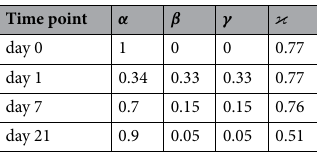
Table 1. Weight values of TC-iReMet2’s objective function and biomass fraction values at each analyzed time